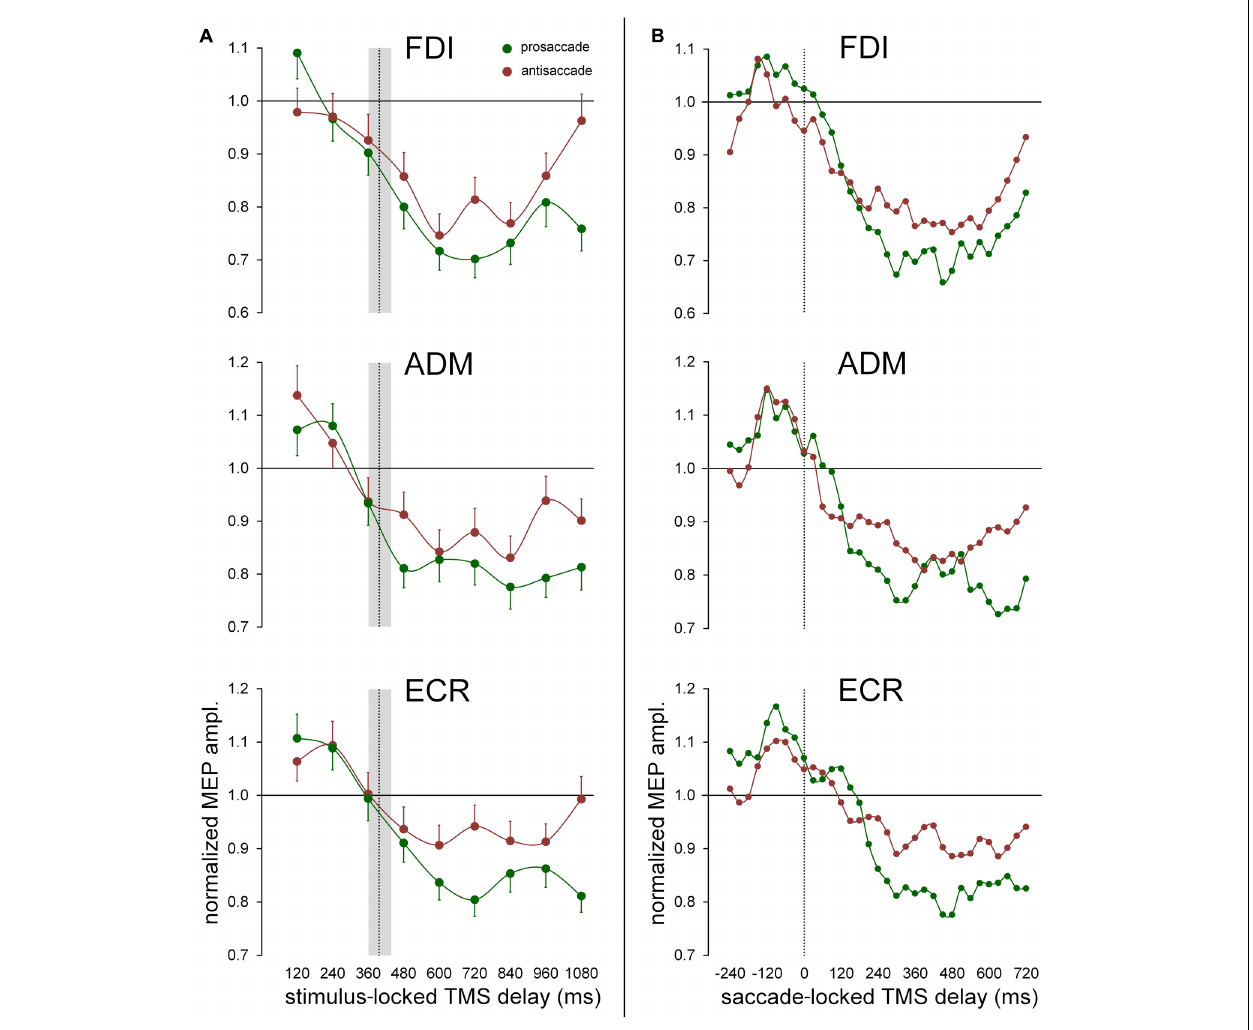
FIGURE 5 | Effect of the ocular task on mean MEP amplitudes. Green and red data points represent mean values across subjects for pro- and anti-saccades respectively, irrespective of gaze direction. Continuous lines represent a spline interpolation of the data. (A) Mean values were computed as a function of TMS delay with respect of the onset of the visual stimulus (‘stimulus-locked TMS delay’). The vertical dotted line depicts the median value of saccade latencies and the gray shade indicates the interquartile range. Error bars represent the standard errors of the mean. (B) Data points represent a moving average computed every 30 ms, on saccade-locked TMS delays falling within a range of ± 60 ms around the plotted value. Vertical dotted line marks the saccade